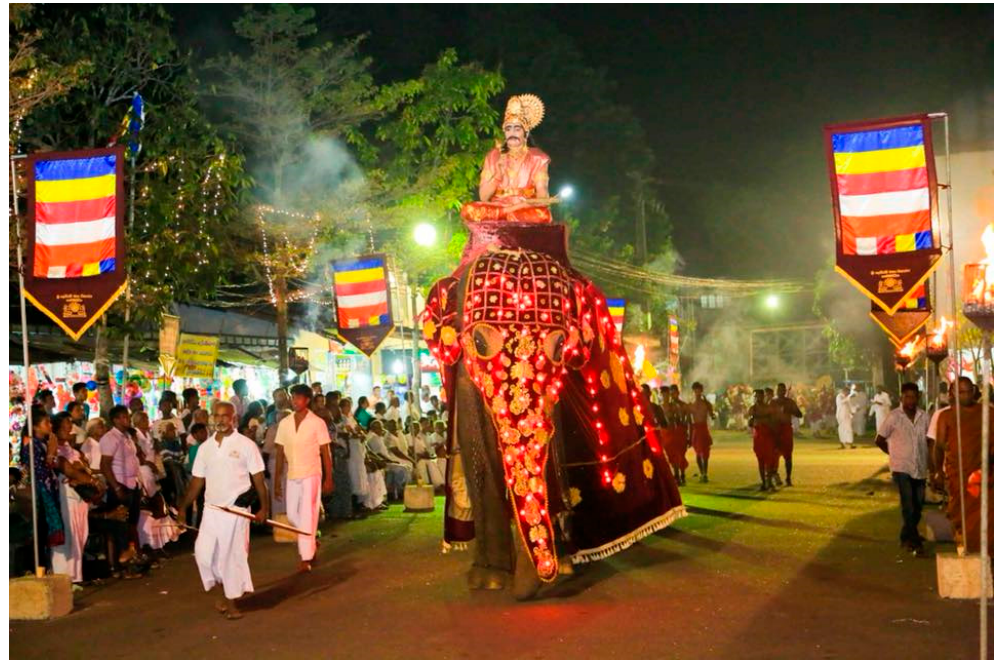
Figure 6. The statue of Ravana taken around in the Medin maha Perahera organized by the Sri Devram Maha Viharaya in Pannpipitiya on 24 March 2018. The picture was published on the Facebook Webpage Sri Devram Maha Viharaya (2018b).